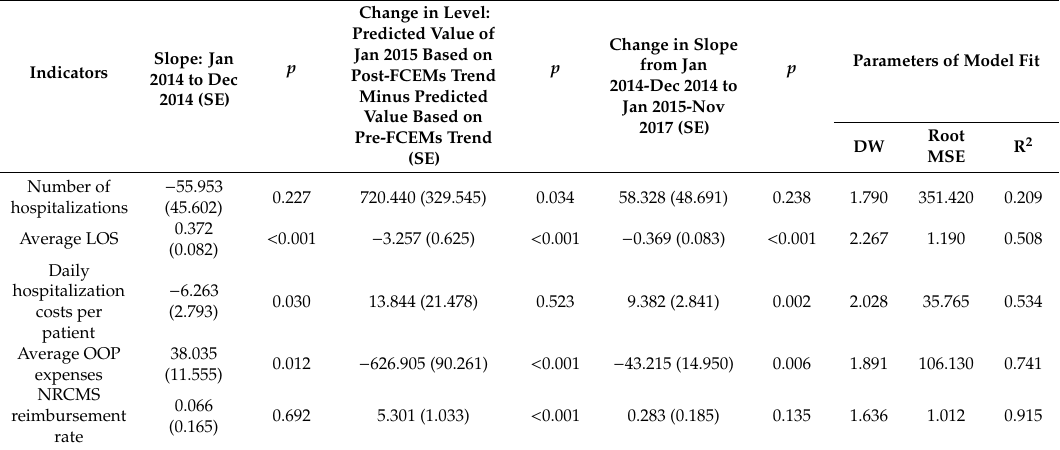
Table 4. The changes in trend and level estimated by ITS regression analysis after correcting for